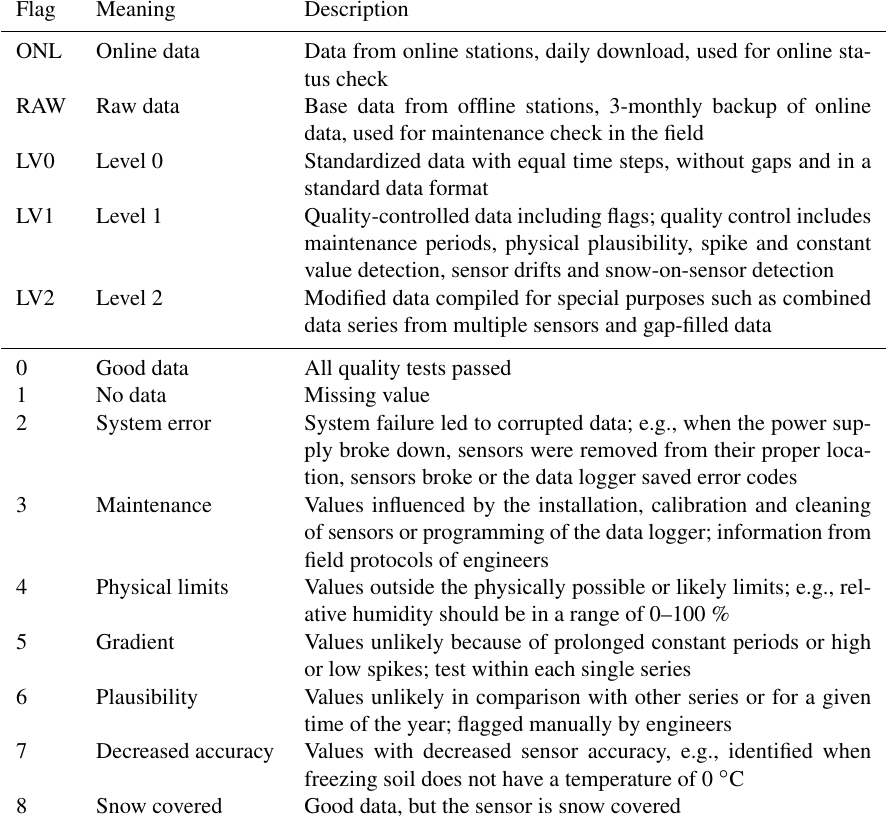
Table 3. Description of data level and quality control for data flags. Most flags are run automatically; few are done manually (e.g., three for maintenance, six for